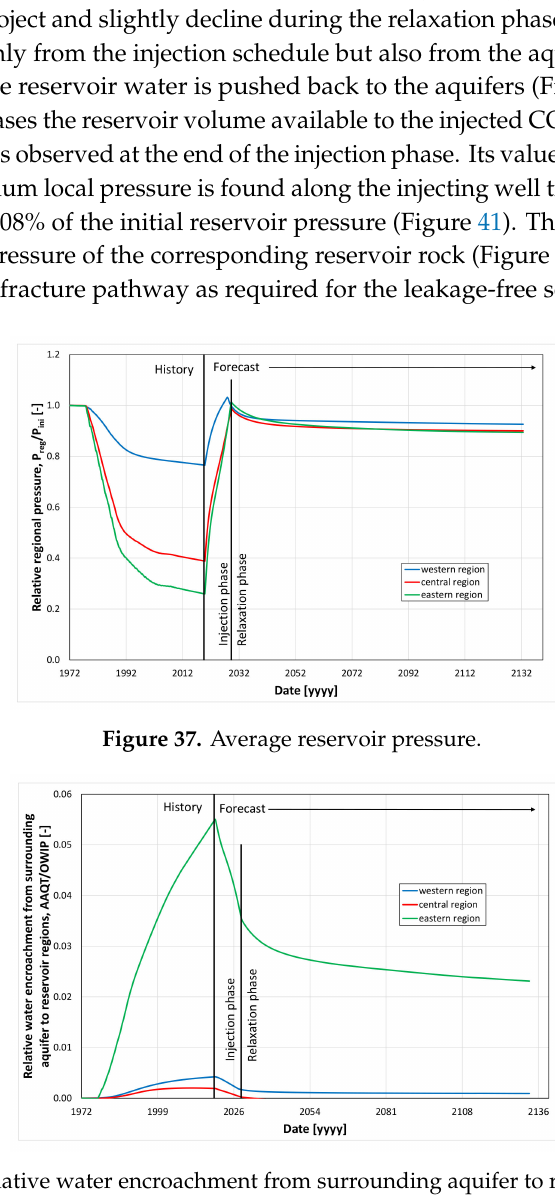
Figure 38. Relative water encroachment from surrounding aquifer to reservoir regions.